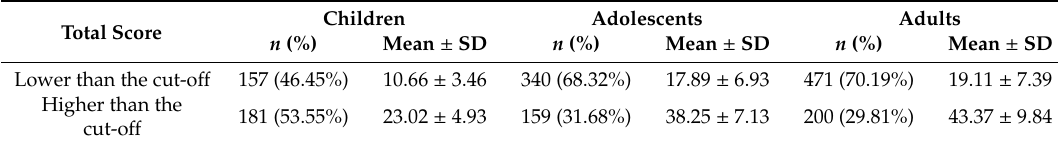
Table 2. IES-total score (IES-TS) questionnaires (mean ± SD). Total